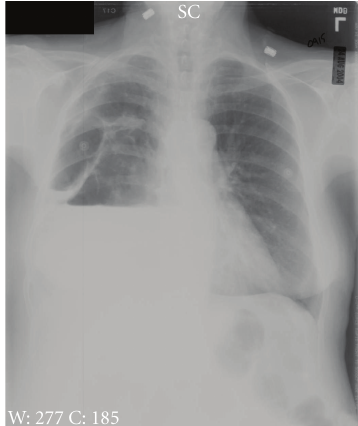
Figure 1: Patient’s initial AP chest radiograph. Increased markings are noted in the right lower lobe, along with a possible small right pleural e ff usion.